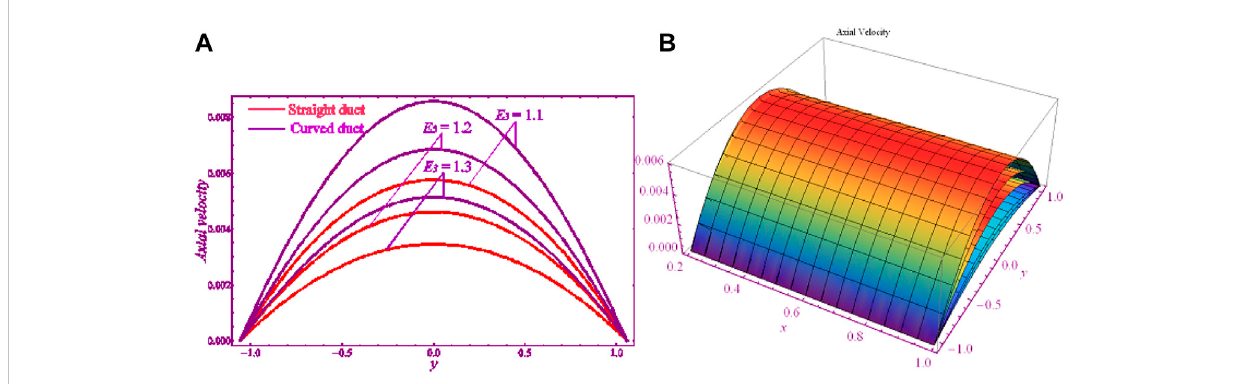
FIGURE 5 Axial velocity pro fi le for fl exure rigidity, E 3 . (A) 2D. (B) 3D.